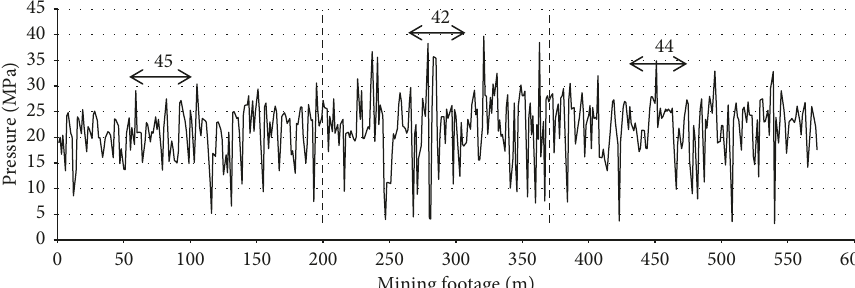
Figure 11: Hydraulic support resistance monitoring results of the 8304 working face on roof cutting side.